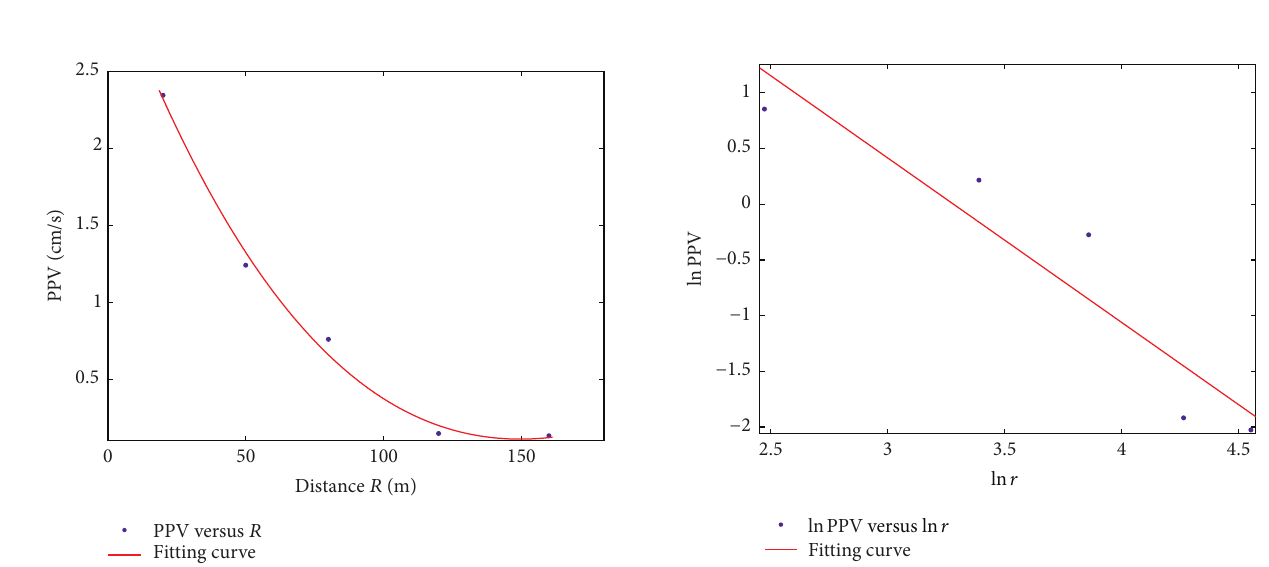
Figure 8: Time history curve of vibration velocity at measuring points with 20 m (a) and 160 m (b) from blasting center.